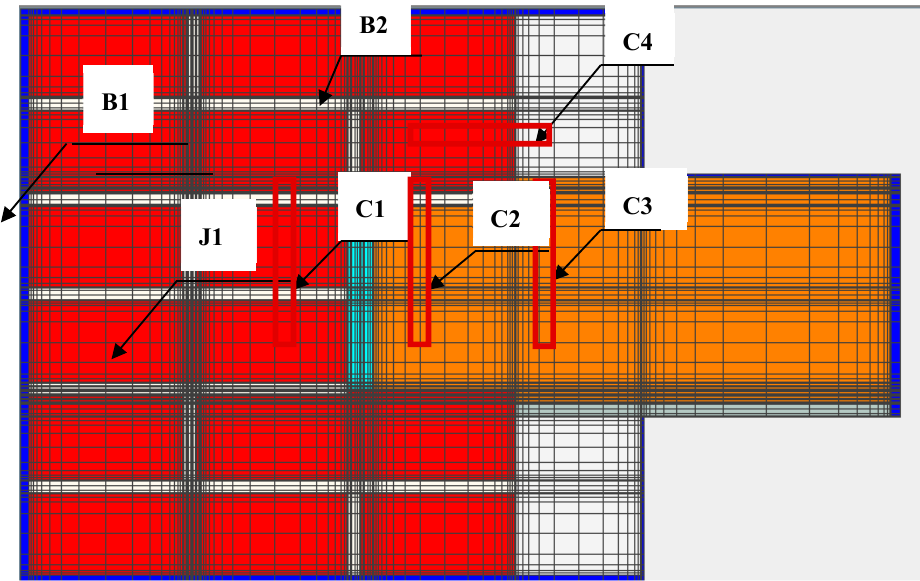
Figure 16. Diagram of the investigated junction between the wooden floor and the insulated wall (B—brick, J—joint, C—wooden ceiling (beam).